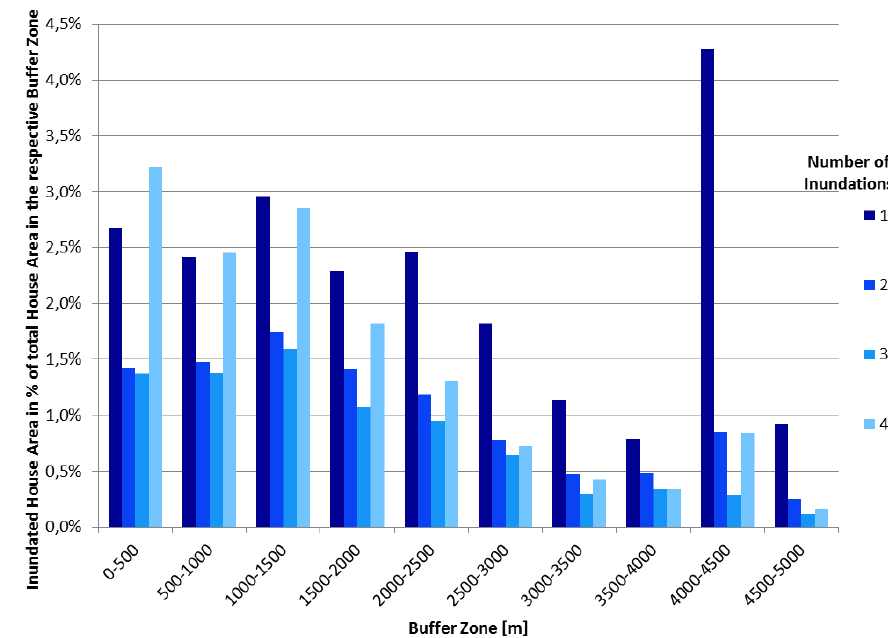
Figure 12. Flooded area in percent of the total house area in the respective buffer zone based on TerraSAR-X Stripmap data for the year